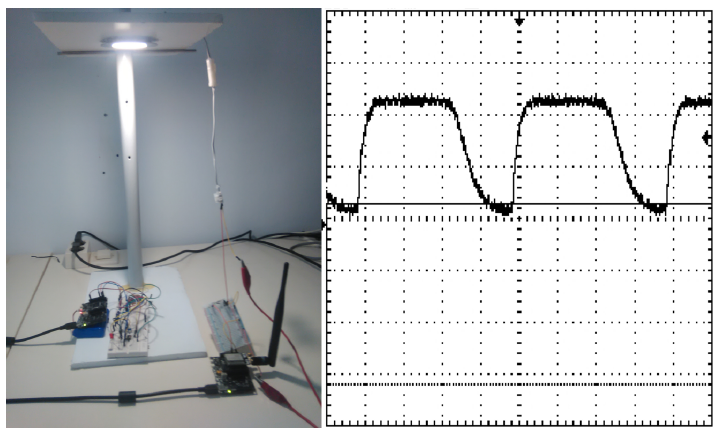
Figure 17. VLC data response through the hybrid network. Vertical resolution: 2 volts/div; horizontal resolution: 500 µ s/div.